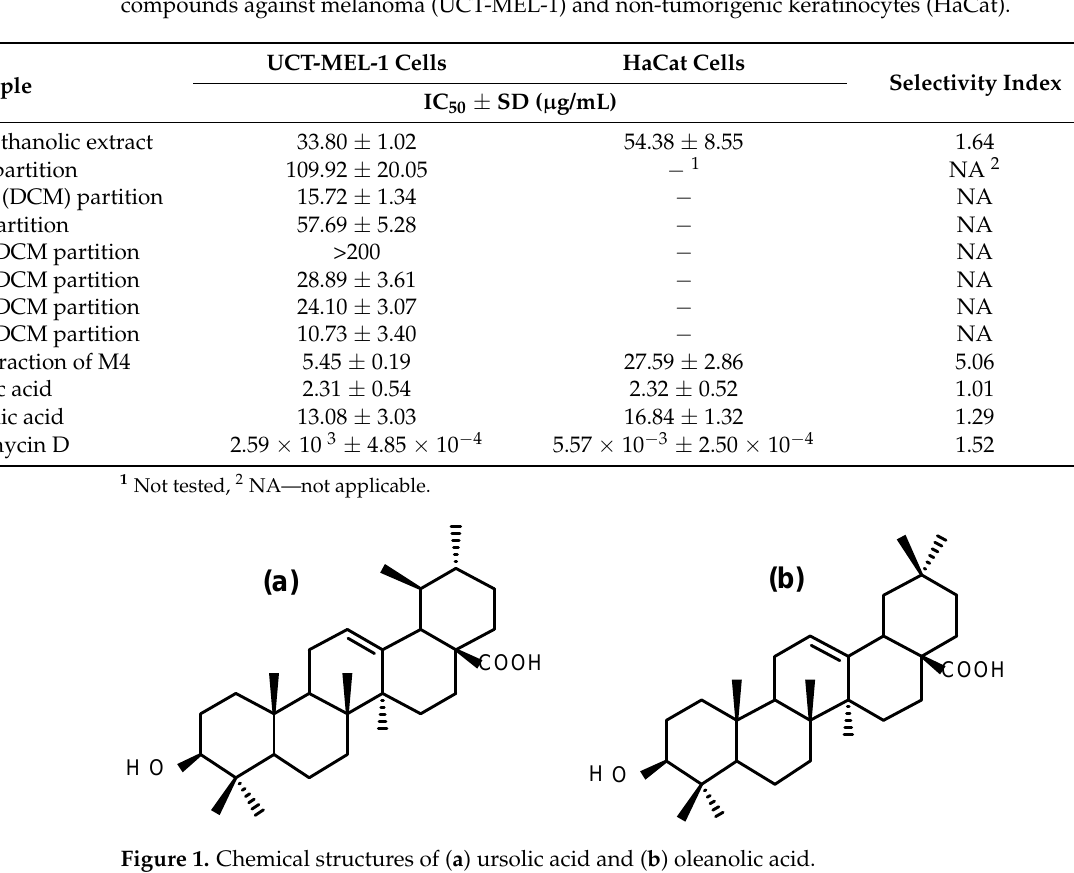
Table 1. Antiproliferative activity of Buddleja saligna ethanolic extract, partitions, major fractions and compounds against melanoma (UCT-MEL-1) and non-tumorigenic keratinocytes (HaCat).